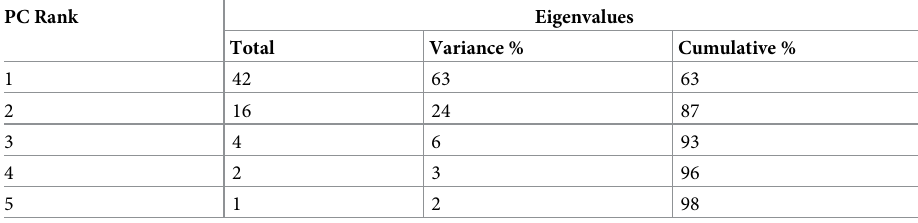
Table 1. Ranking of principal components by eigenvalues.